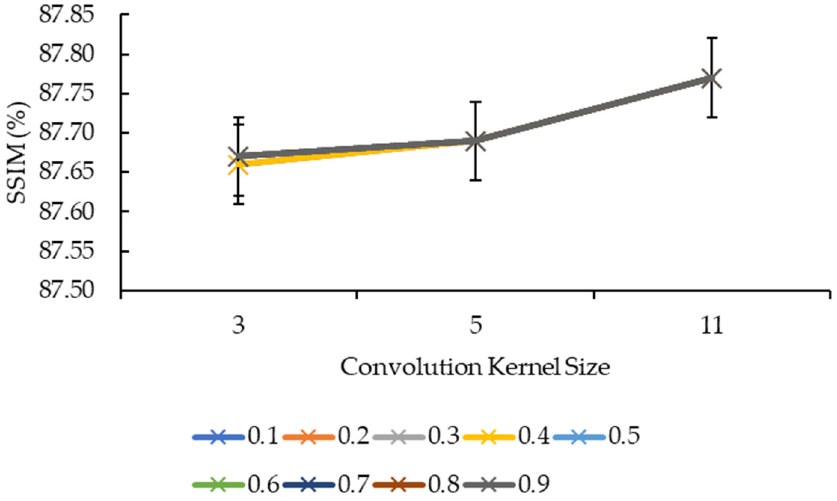
Figure 3. Graph of SSIM against convolution kernel size.